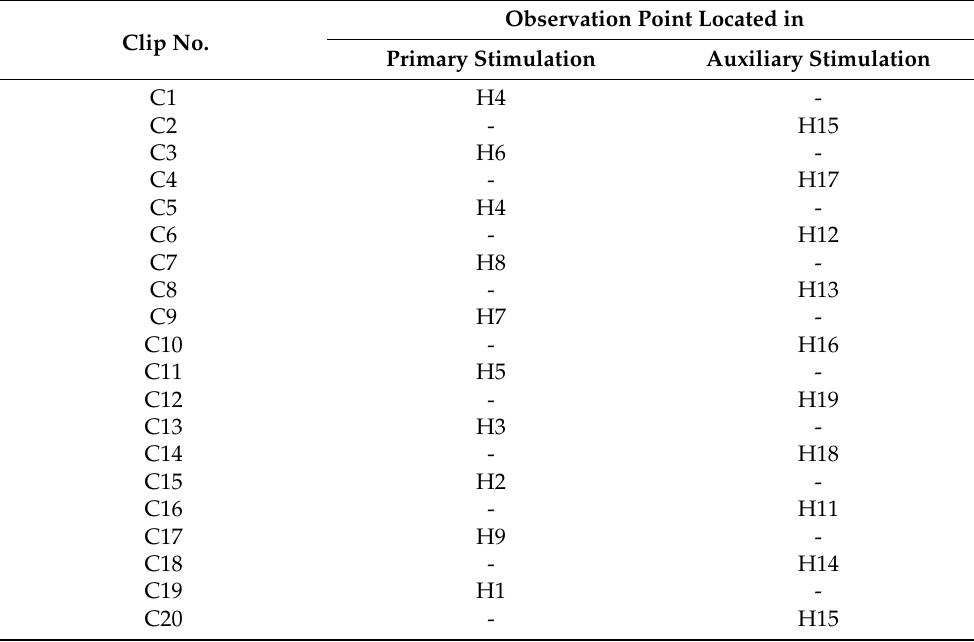
Table 3. One of the random orders to display the video clips converted from selected observation points’ panoramas.